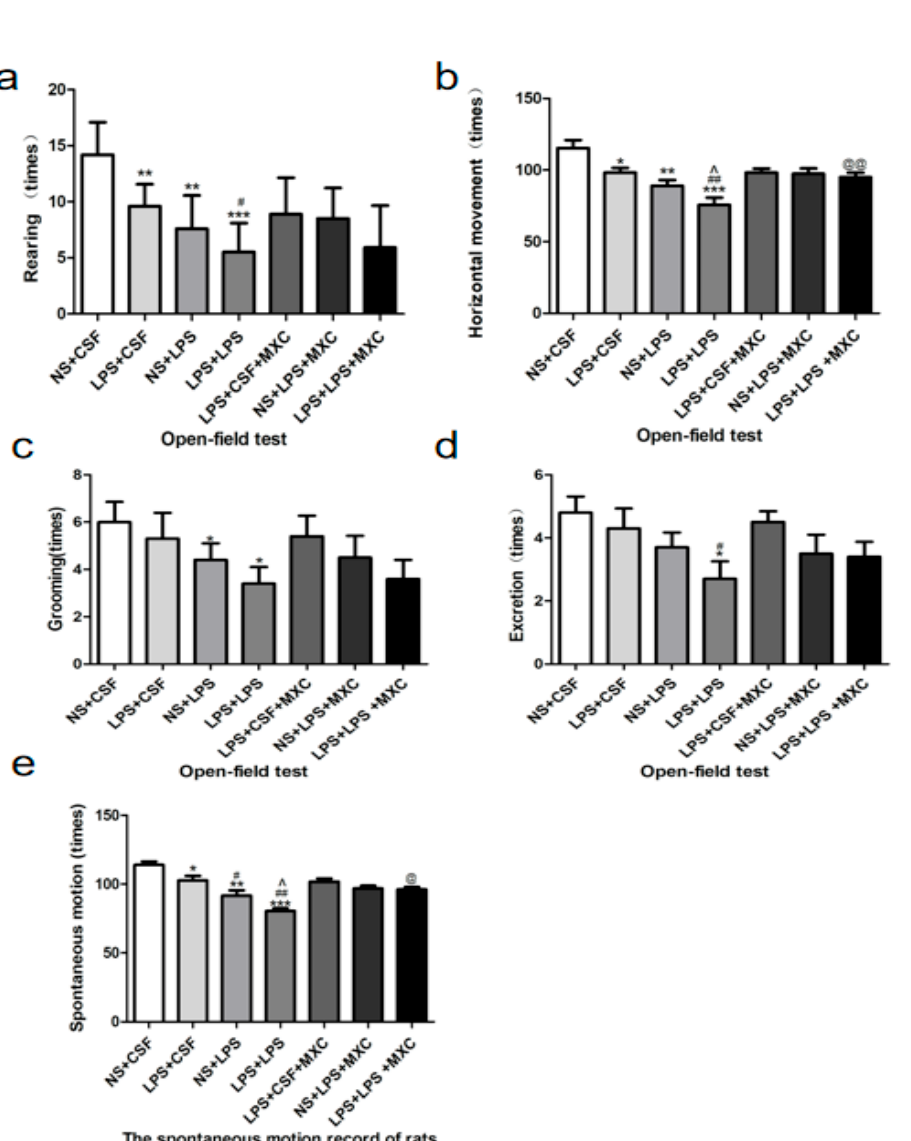
Figure 2. Effect of MXC on the exploratory behavior and spontaneous locomotor activity in LPS-treated offspring after prenatal inflammation exposure: ( a ) rearing behavior, ( b ) horizontal movement (times), ( c ) grooming episodes, and ( d ) amount of defecation during the 5 min trial period. ( e ) Effect of MXC on the spontaneous motor activity in LPS-treated offspring from prenatal inflammation exposure. Data are mean ± SEM, n = 9–10. (* p < 0.05, ** p < 0.01, *** p < 0.001 vs. NS + CSF group; # p < 0.05, ## p < 0.01 vs. LPS + CSF group; ^ p < 0.05 vs. NS + LPS group; @ p < 0.05, @@ p < 0.01 vs. LPS + LPS group) .